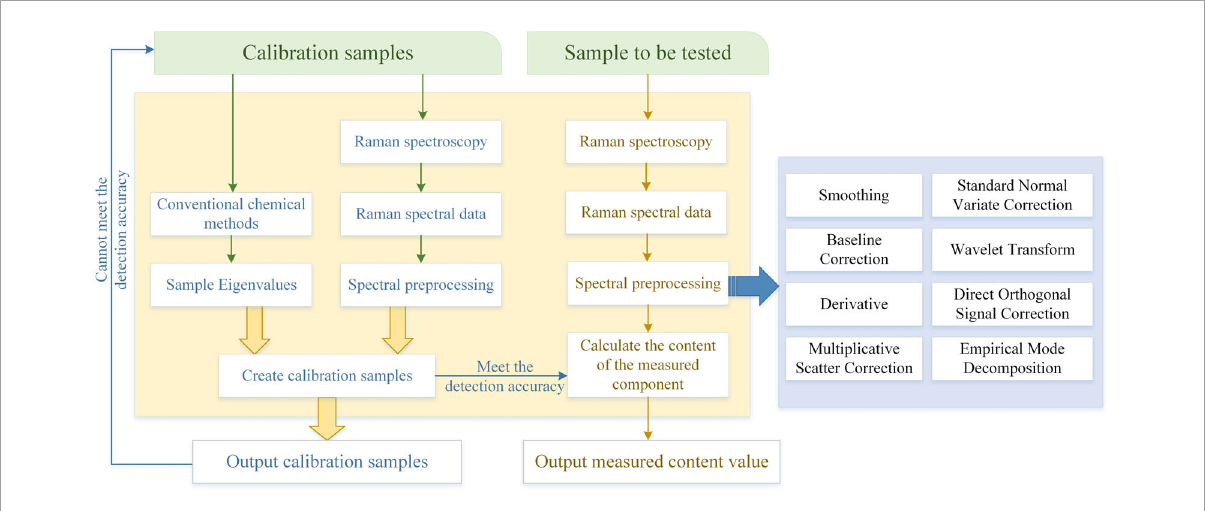
FIGURE5 Flow chart of quantitative KPCA for SERS.